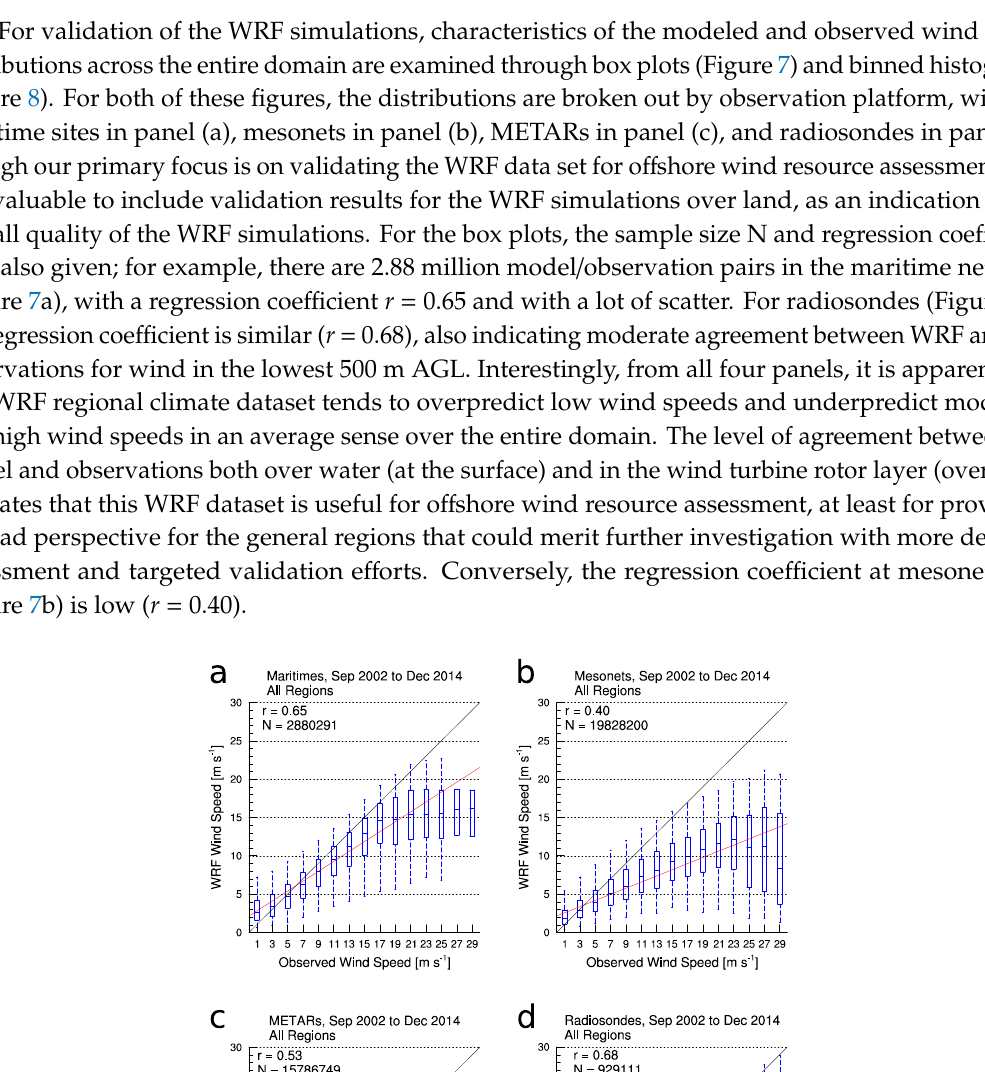
Figure 8. Binned histograms of wind speed from the WRF model (solid filled bars) and observations (hatched/stippled bars), for the ( a ) maritime, ( b ) mesonet, ( c ) METAR, and ( d ) radiosonde networks, spanning September 2002–December 2014. The bin width is 2 m s − 1 .